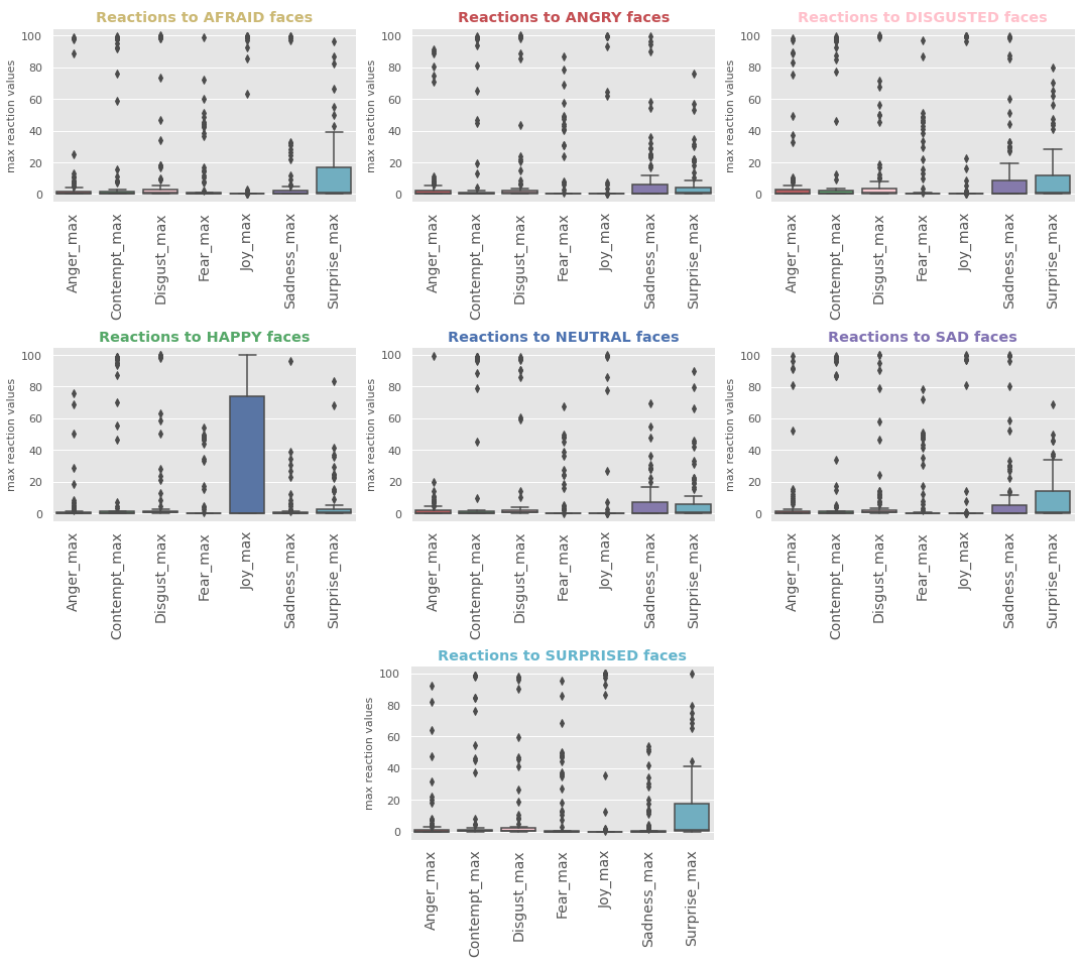
Figure 8. Facial reactions vs. stimuli boxplots generated by considering all the maximum values for each reaction and stimulus. Each plot represents the data for one type of emotional stimuli, with x-axis representing the types of reaction and y-axis representing the maximum reaction probability scores.